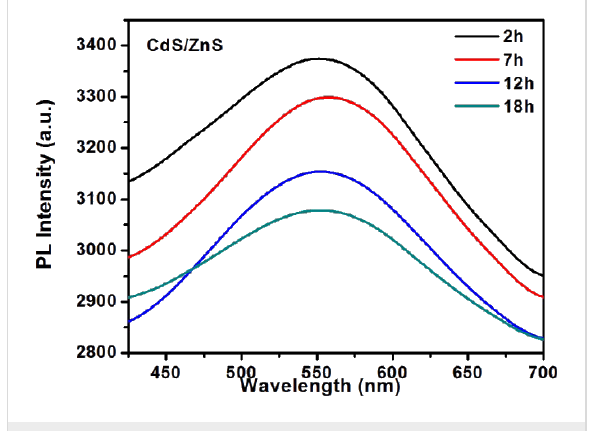
Figure 7: CdS/ZnS PL spectra for photobleaching.